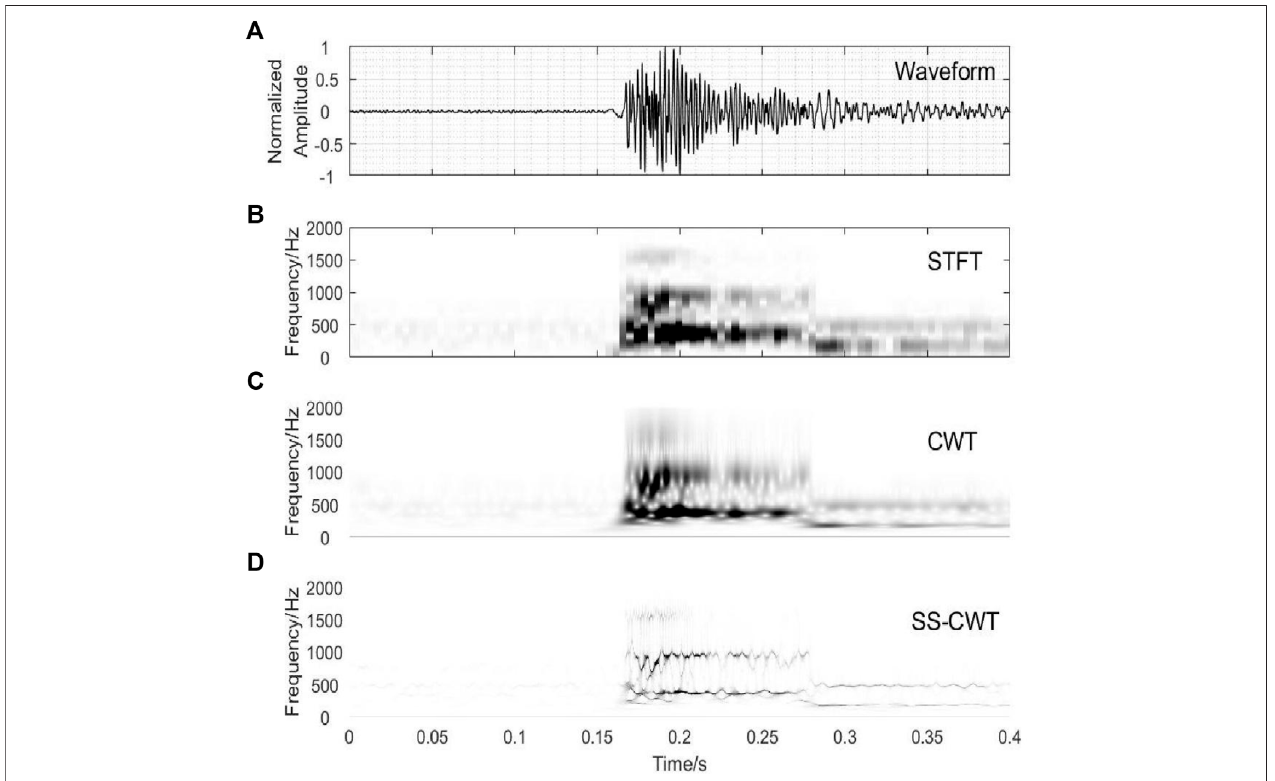
FIGURE 1 | Time-frequency Spectrum of a seismic record using STFT, CWT, and SSWT. (A) Field mine microseismic signal with high SNR, the sampling rate is 6000 Hz. (B) (C) , and (D) shows the STFT, CWT, and SS-CWT of the time series in (A) , respectively, where CWT and SS-CWT are both based on the Morlet wavelet.